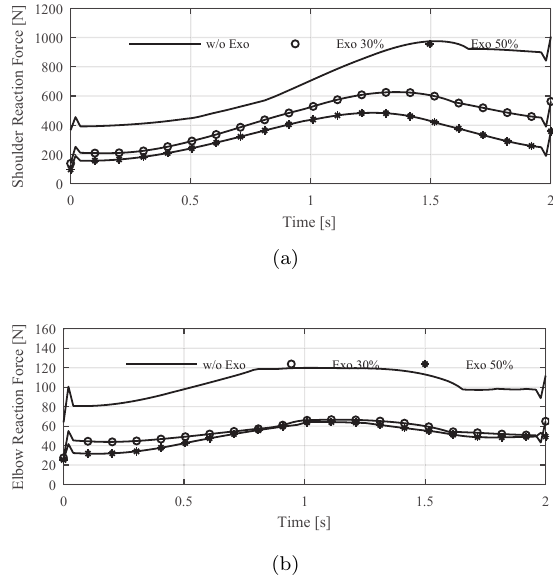
Figure 15: Magnitude of joint reaction forces in the human musculoskeletal system during the overhead reach, (a) shoulder glenohumeral joint, (b) elbow joint